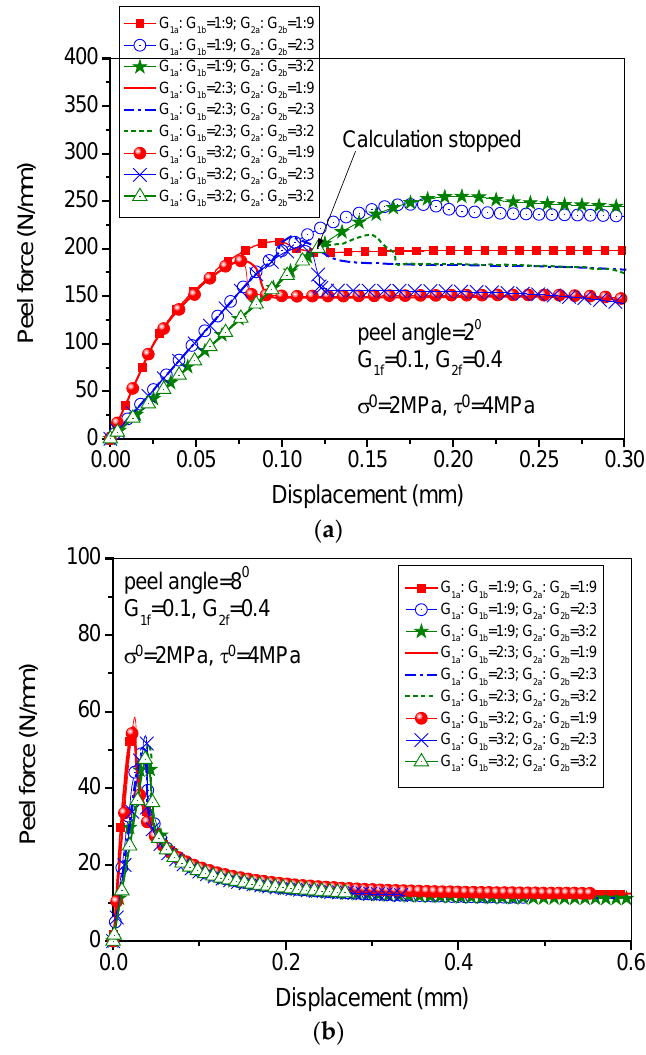
Figure 11. Effect of G a /G b ratio on the load-displacement behavior: ( a ) peel angle = 2 degree; ( b ) peel angle = 8 degree.